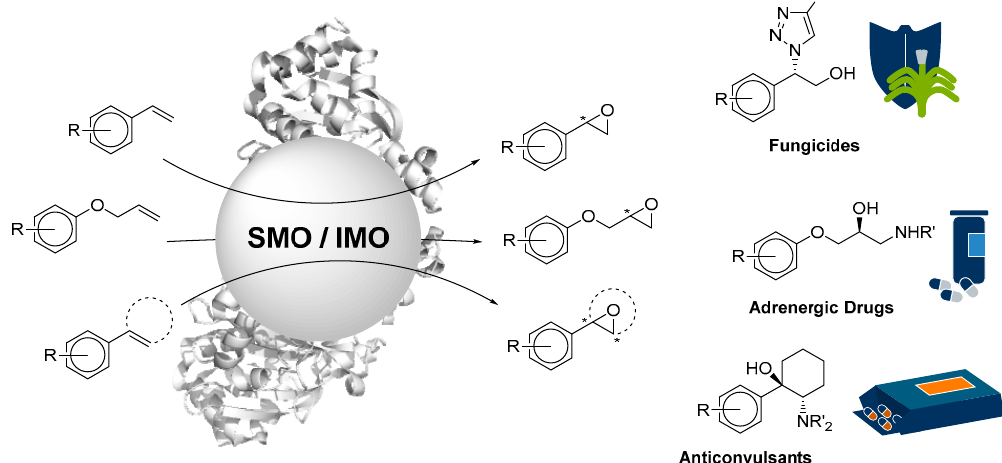
Figure 1. Styrene and indole monooxygenases activate double bonds by chiral epoxidation. Those epoxide intermediates are valuable building blocks in the chemical industry and can be further processed toward fine chemicals.